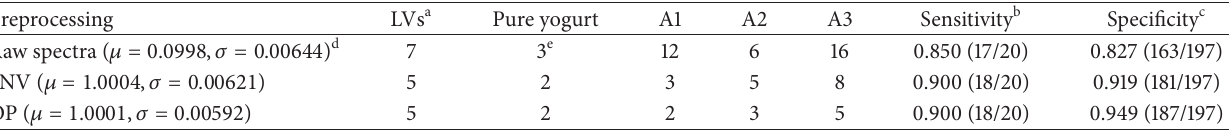
Table 2: Predicting results of OCPLS models for pure and adulterated yogurt